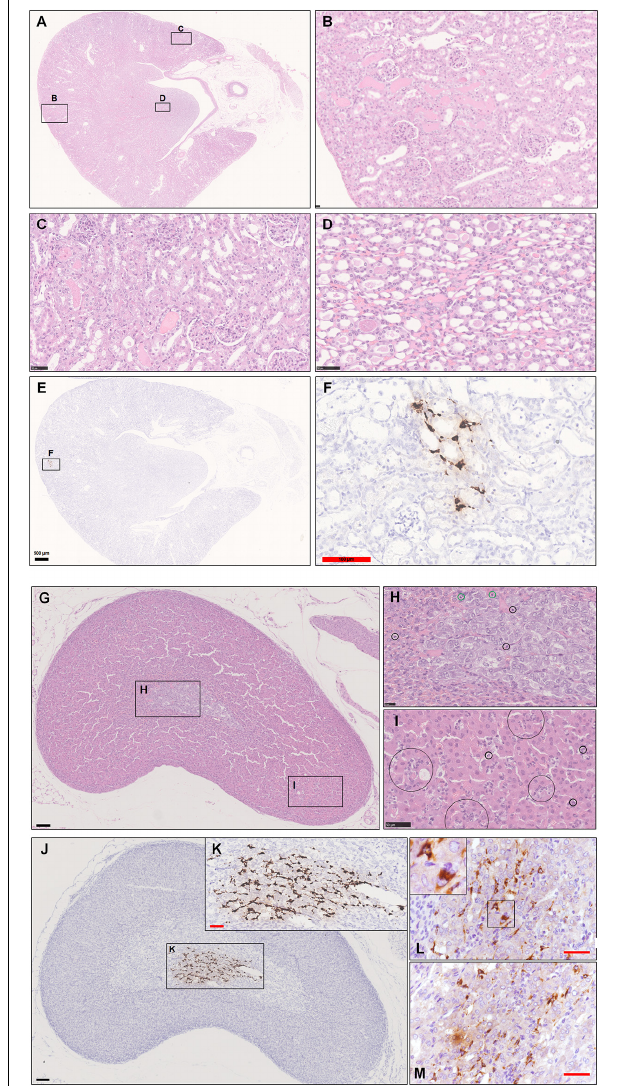
FIGURE 5 | Observation and examination of the kidney and adrenal glands at 5 dpi. (A–D) The kidney lesions were characterized primarily by coagulation necrosis with occasional detachment of the epithelium from the tubular basement membrane. Some proteinaceous debris was present in the dilated proximal and distal tubules or collecting tubules. (E,F) Low viral RNA expression was also detected by ISH in the renal tubules. (G–I) Scattered inflammatory cells, mainly including neutrophilic cells (black circle in H,I ) and lymphocytes (green circle in H ), in the adrenal cortex and medulla. (J,K) Robust viral RNA expression was detected by ISH in the adrenal medulla. (L,M) Abundant viral S protein expression was detected by IHC in the cytoplasm. The black frames in the corner of L is the magnification of the framed region. Sequential sections were stained by H&E and subjected to ISH, IHC, and IF. Data are representative of three independent